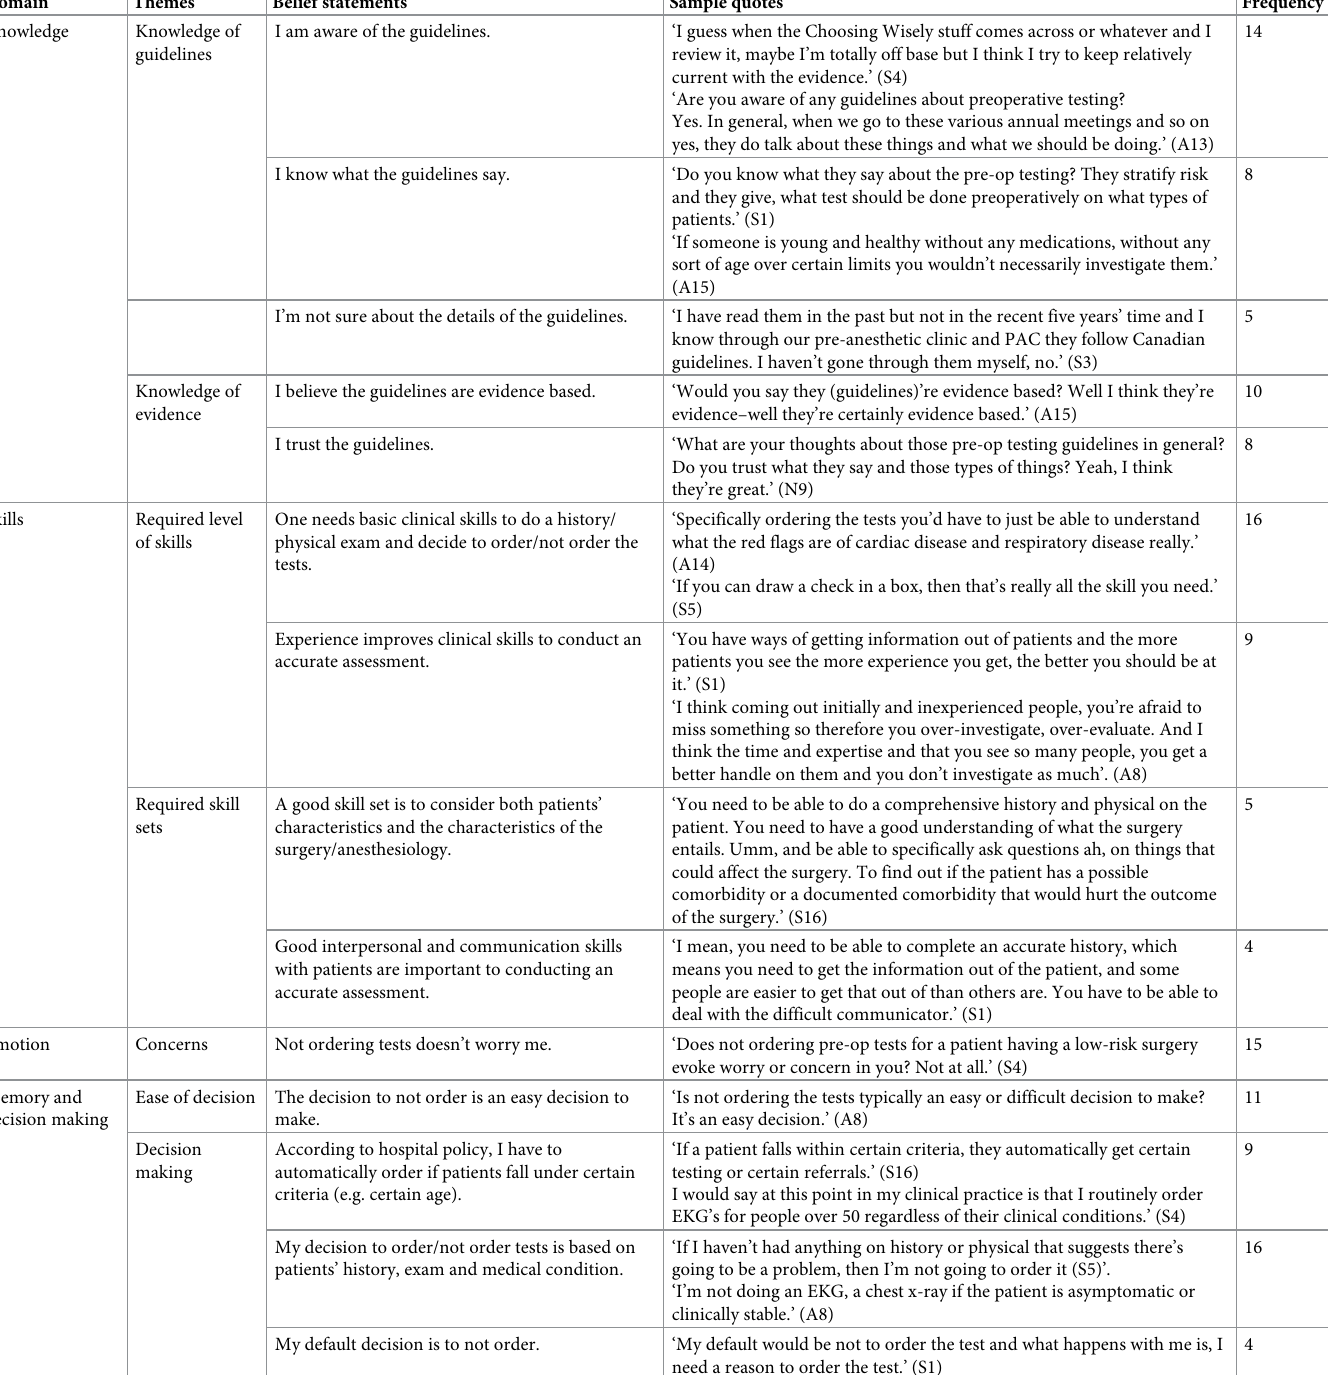
Table 2. Summary of belief statements and sample quotes from anesthesiologist, surgeons and nurses assigned to the theoretical domains identified as irrelevant.